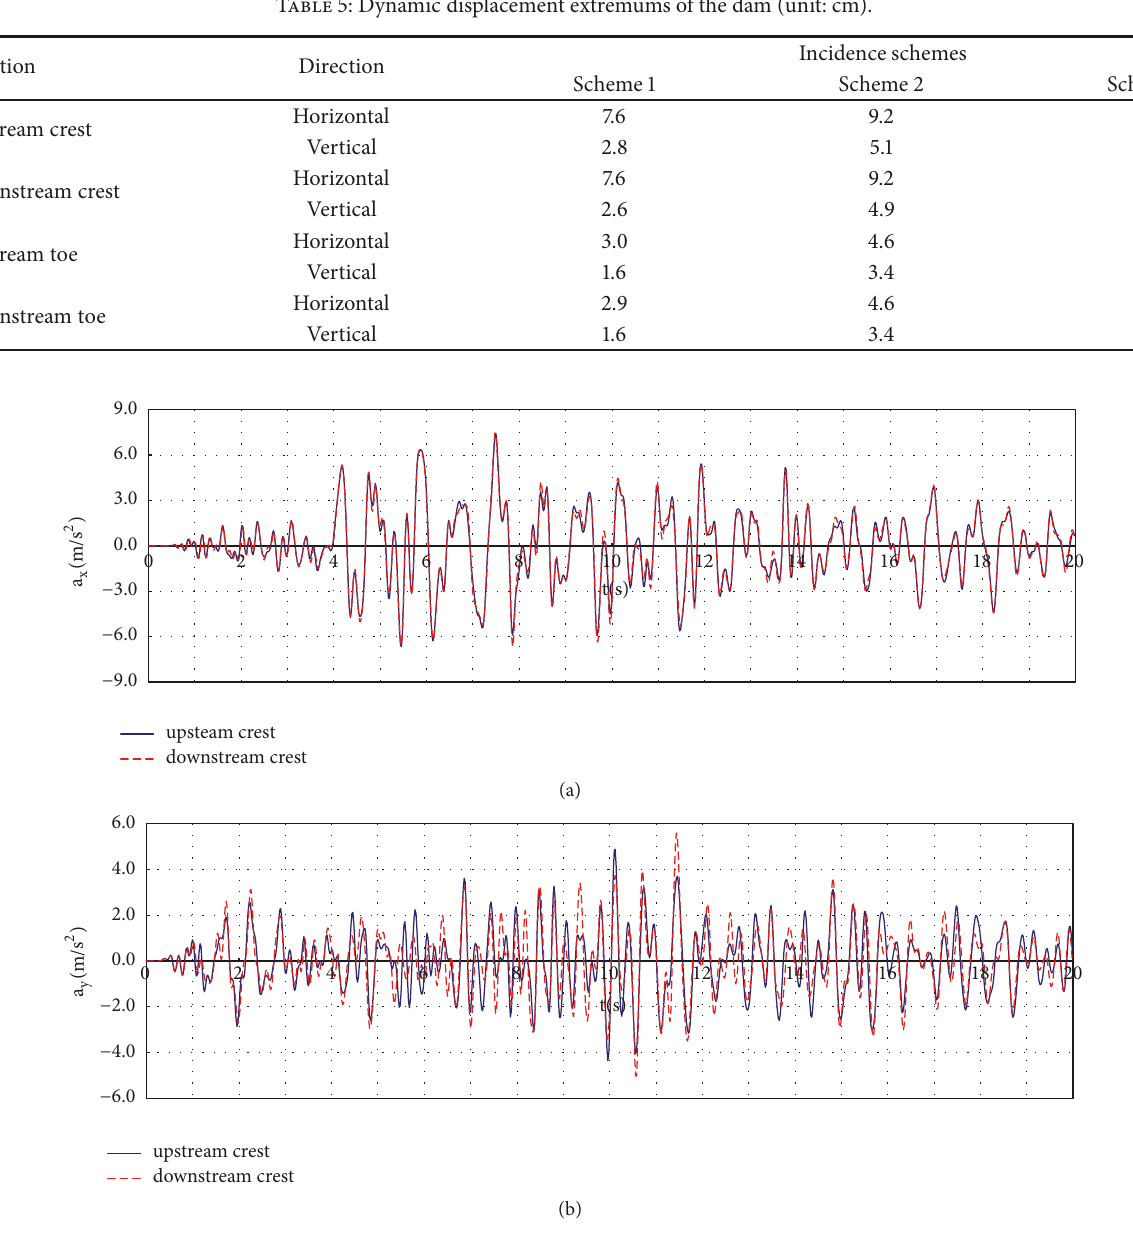
Figure 21: Time histories of acceleration at the upstream crest and downstream crest: (a) horizontal and (b)